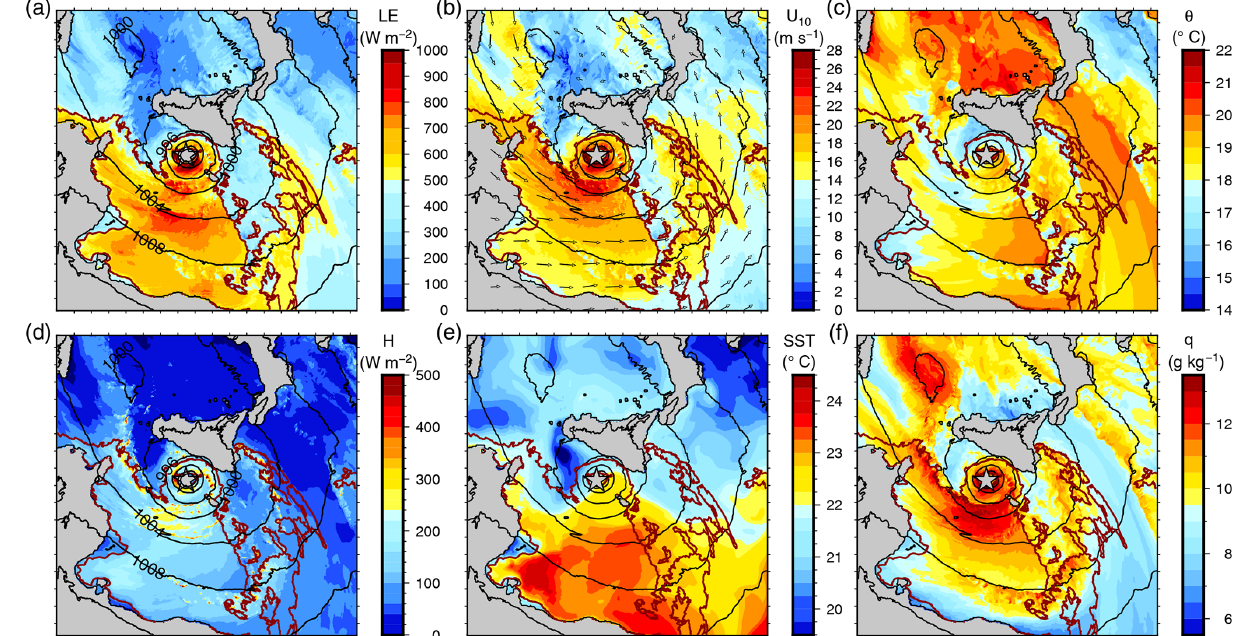
Figure 16. Same as Fig. 13 but at 13:00UTC on 7